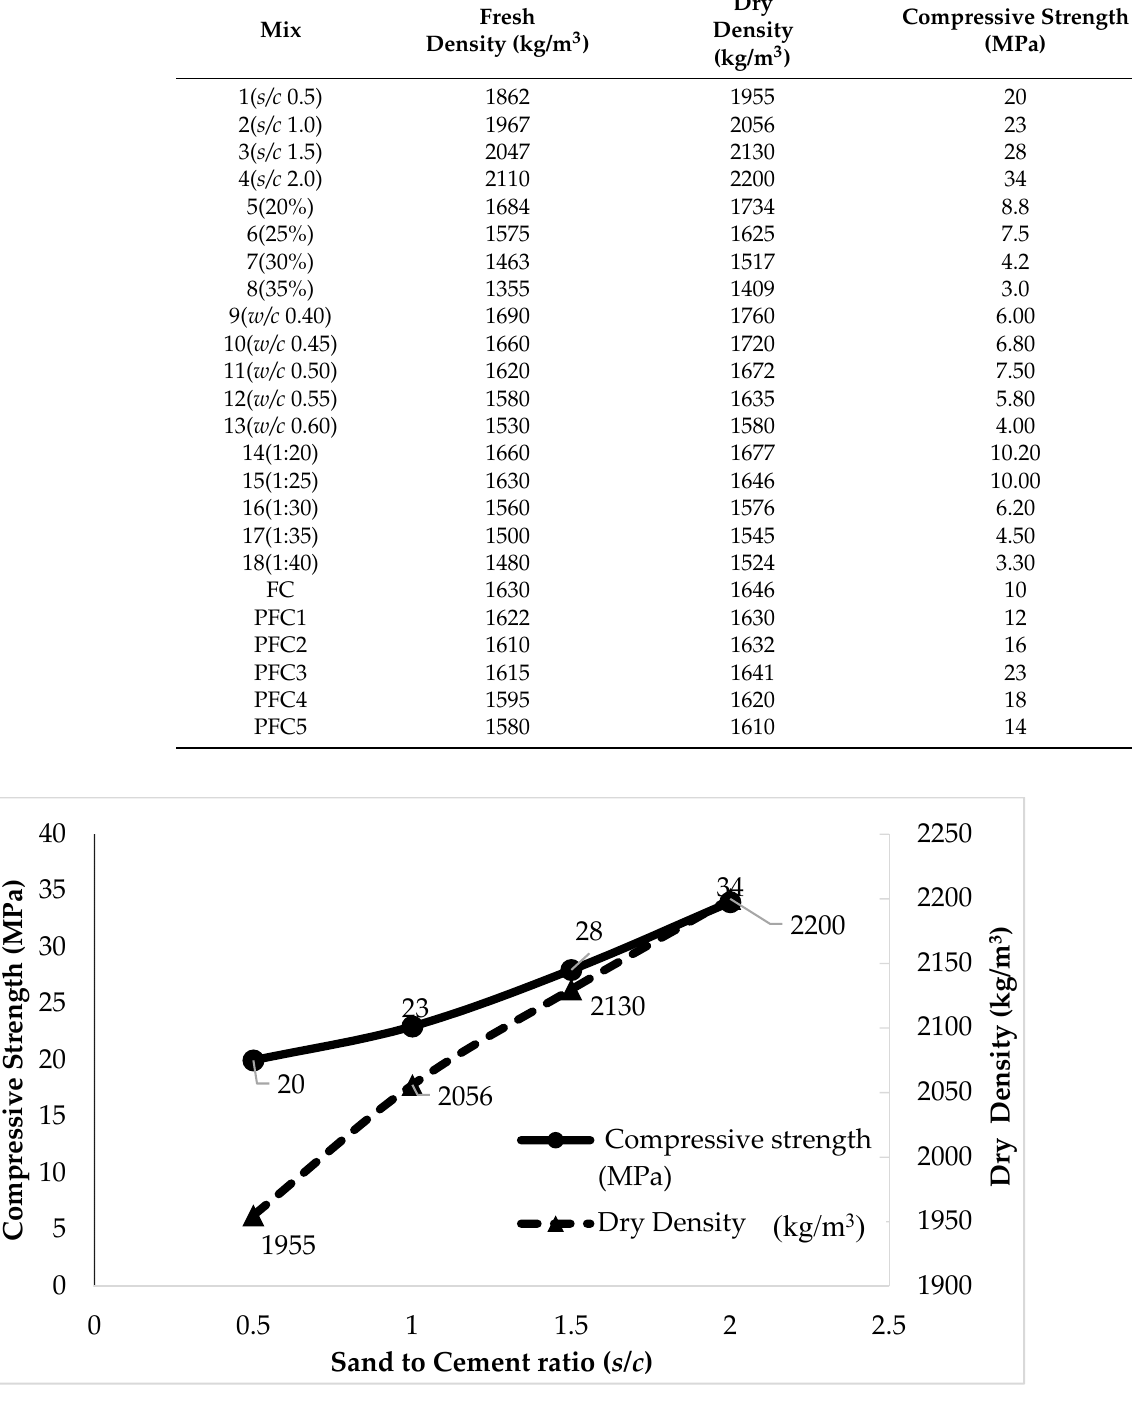
Figure 3. Relationship between compressive strength and density of mortar at four different s/c ra- tios.